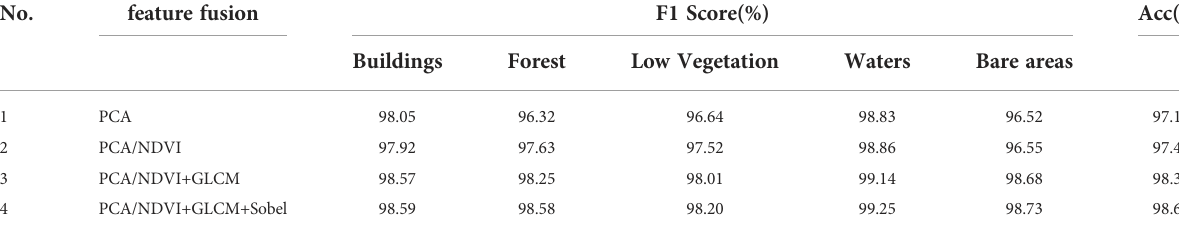
TABLE 3 The in fl uence of different feature fusion ways on experimental results.